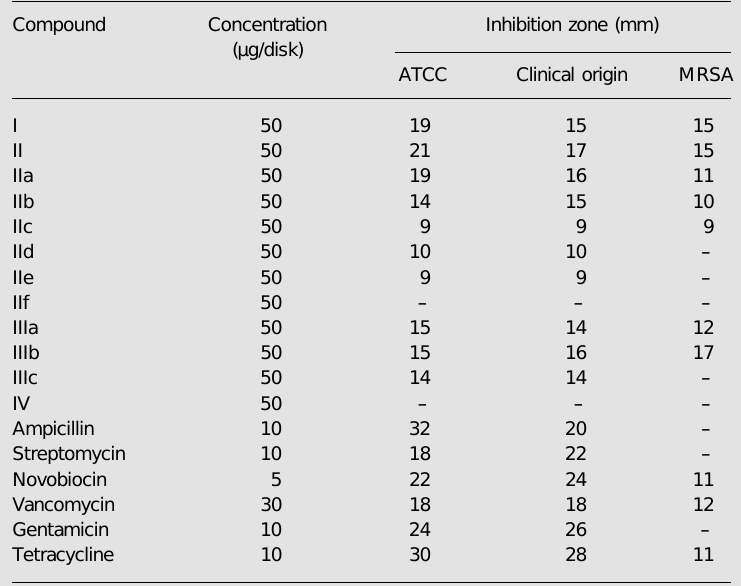
Table 1. Susceptibility of Staphylococcus aureus to naphthoquinones. Compound